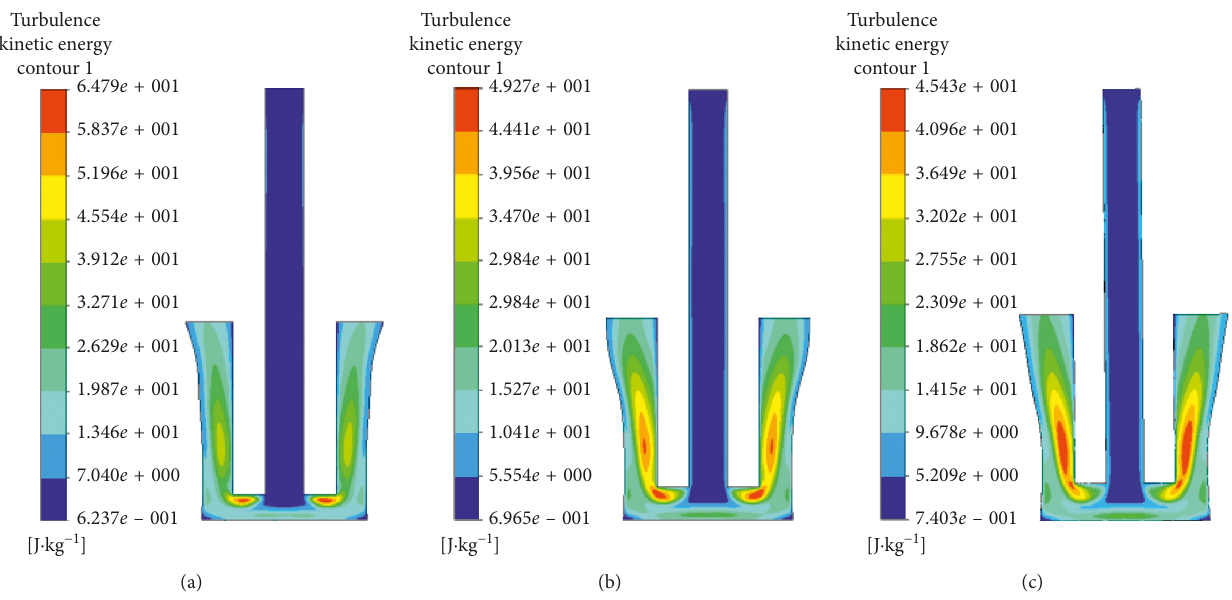
Figure 17: Electrolyte flow eddy distribution under different electrolyte concentrations. (a) U � 9V, ξ � 7%. (b) U � 9V, ξ � 11%. (c) U � 9V, ξ �